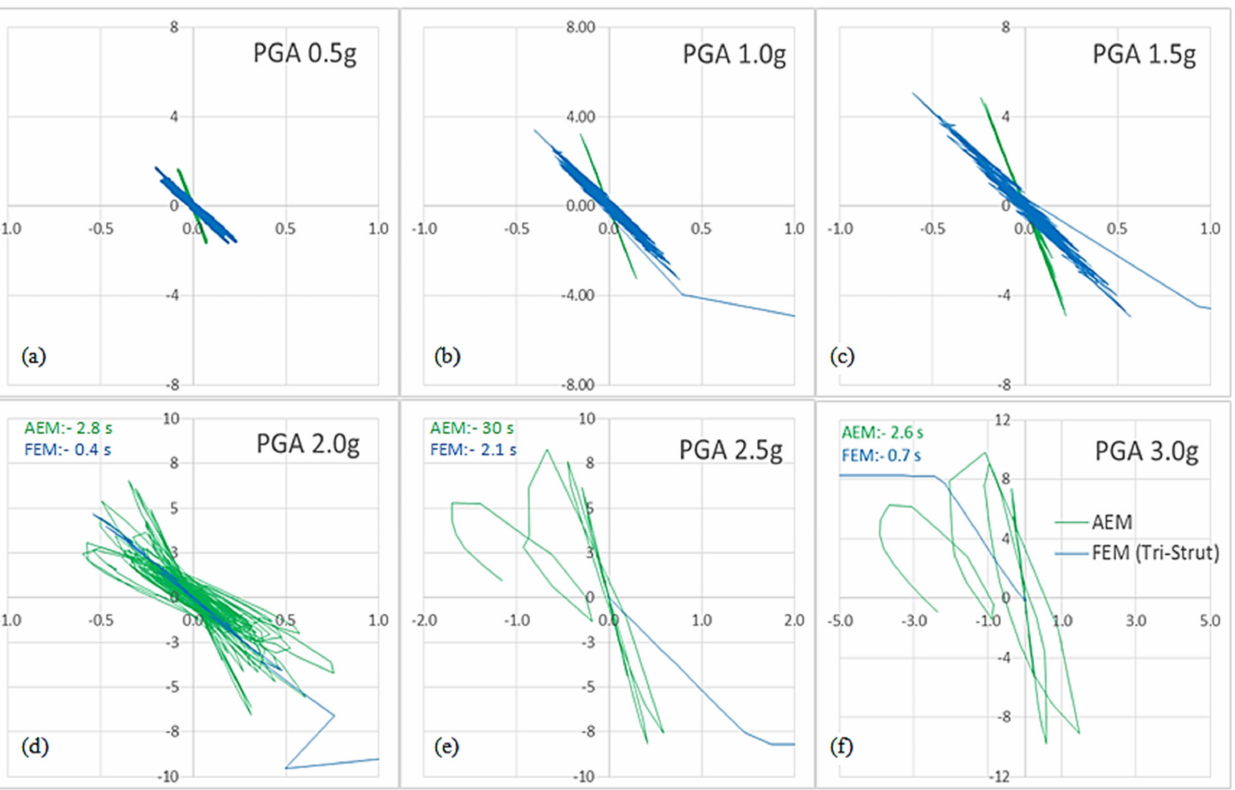
Figure 25. Comparison of base shear and top lateral displacements for FEMA strut and AEM models for CM wall structure at PGA: ( a ) 0.5 g; ( b ) 1.0 g; ( c ) 1.5 g; ( d ) 2.0 g; ( e ) 2.5 g; ( f ) 3.0